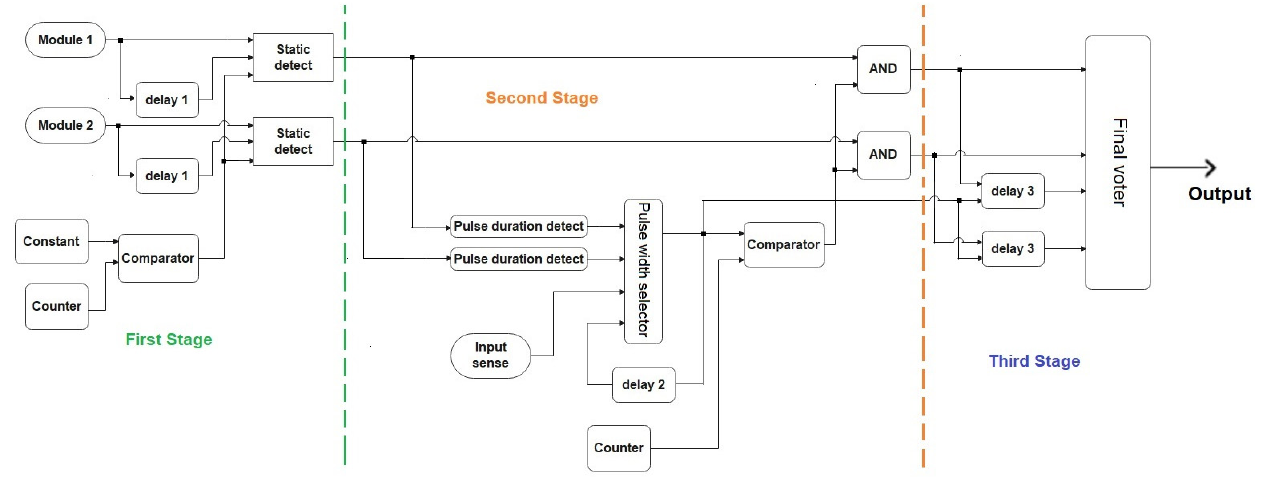
Figure 2. Implementation of the proposed technique for the two-module case. The motivation for the proposed technique rests on the fact that radiation-induced faults result in one or more of the following effects on the DC-DC converter PWM controller output